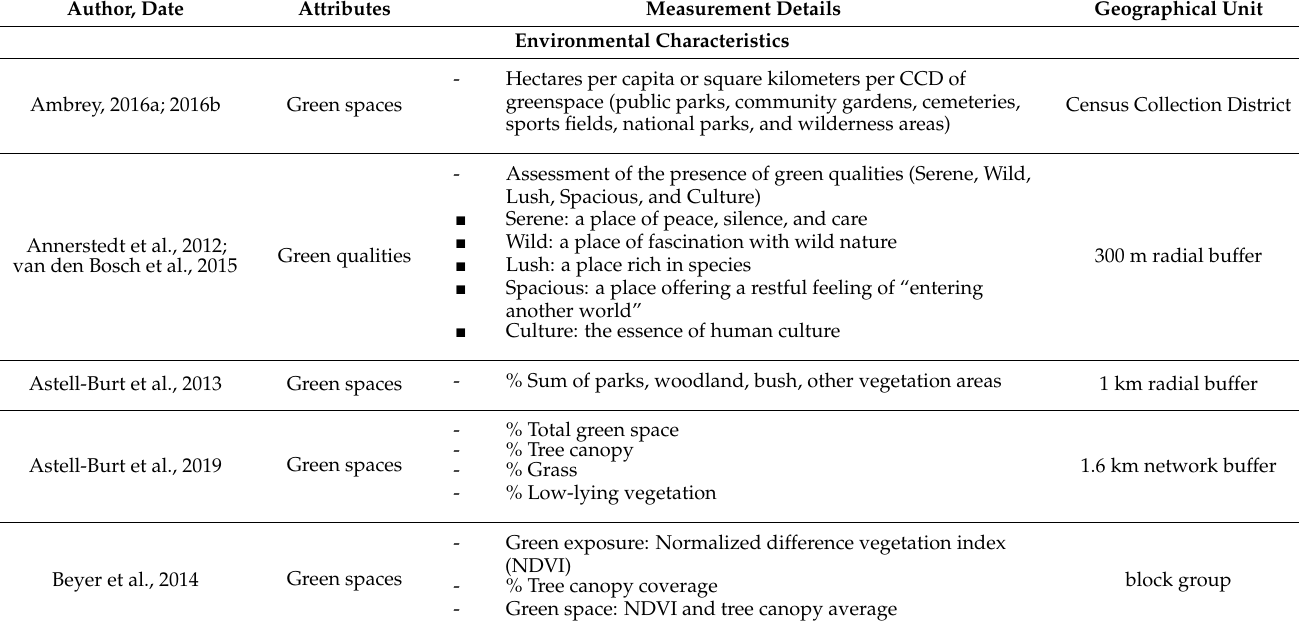
Table 3. Neighborhood attributes, measurements, and geographical